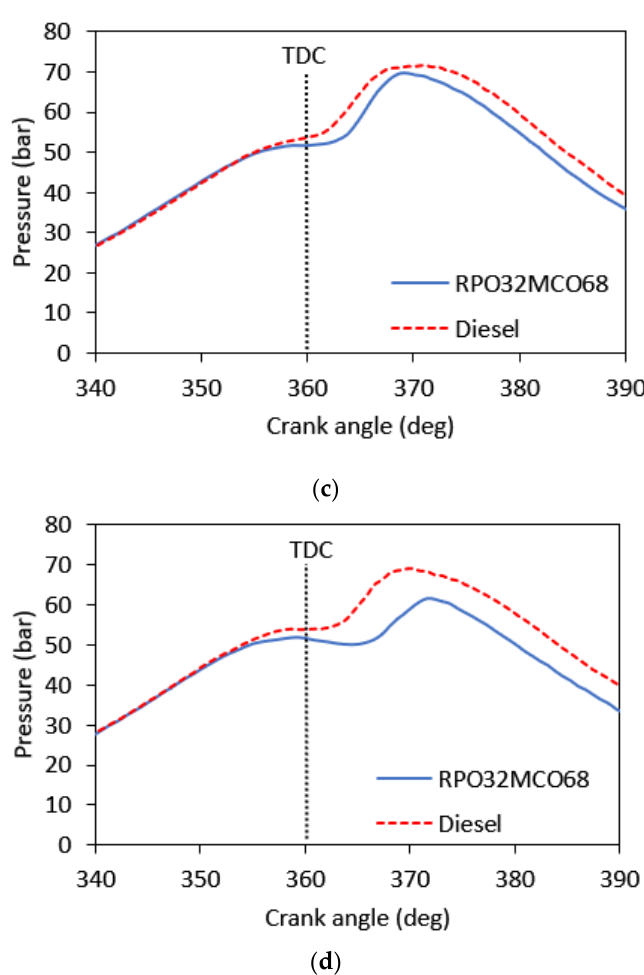
Figure 9. Cylinder pressure versus crank angle degree for tested fuels at ( a ) 2000 rpm; ( b ) 2500 rpm; ( c ) 3000 rpm, and ( d ) 3500 rpm.